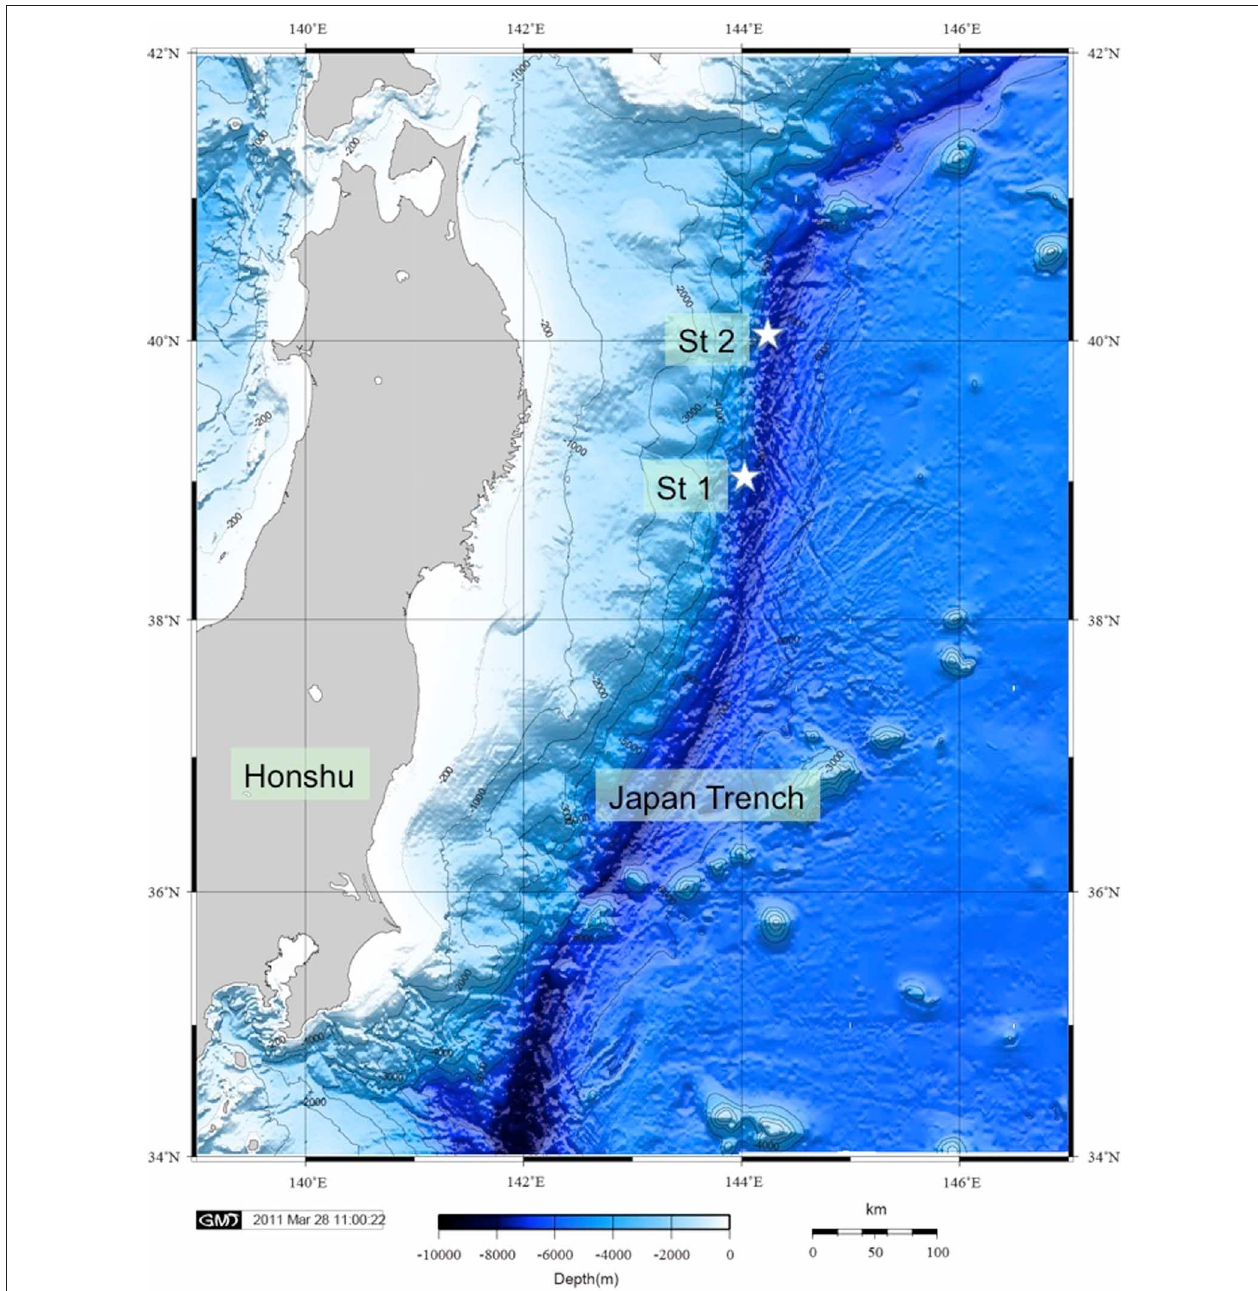
FIGURE 2 | Bathymetric map of the Japan Trench showing the positions of Station 1 and